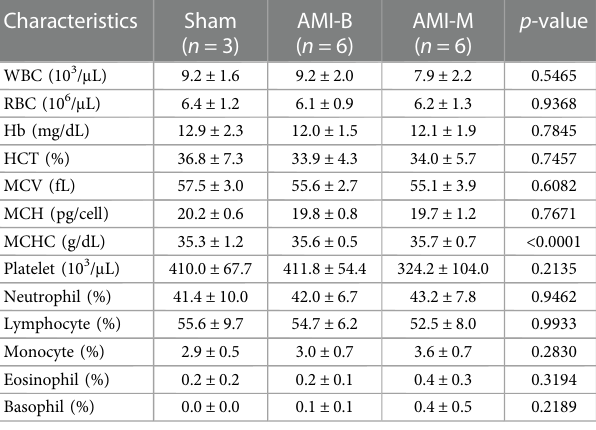
TABLE 2 Hematological characteristics of three groups at 5 months after AMI induction.